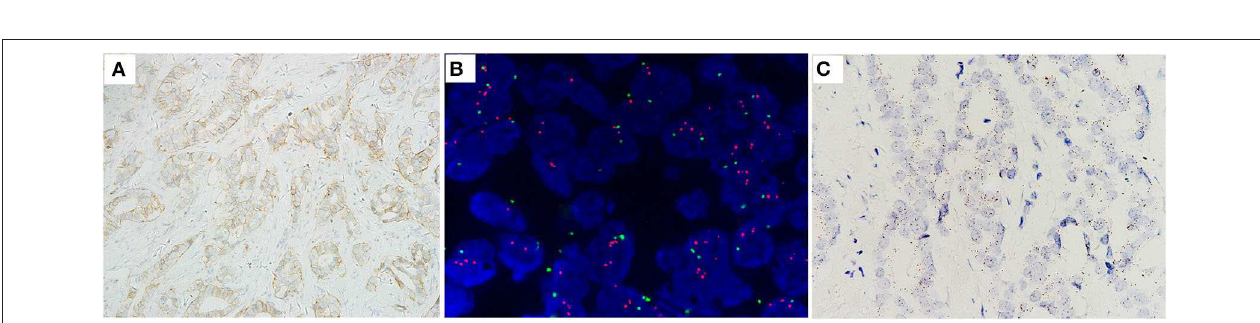
FIGURE 3 | Case no. 19, with IHC2 + (A) , a HER2/CEP17 ratio of 2.26, and the highest average of HER2 signals/cell of 3.95 (B) . Showed low level of HER2 mRNA expression (score 2 by RNAscope) (C) .